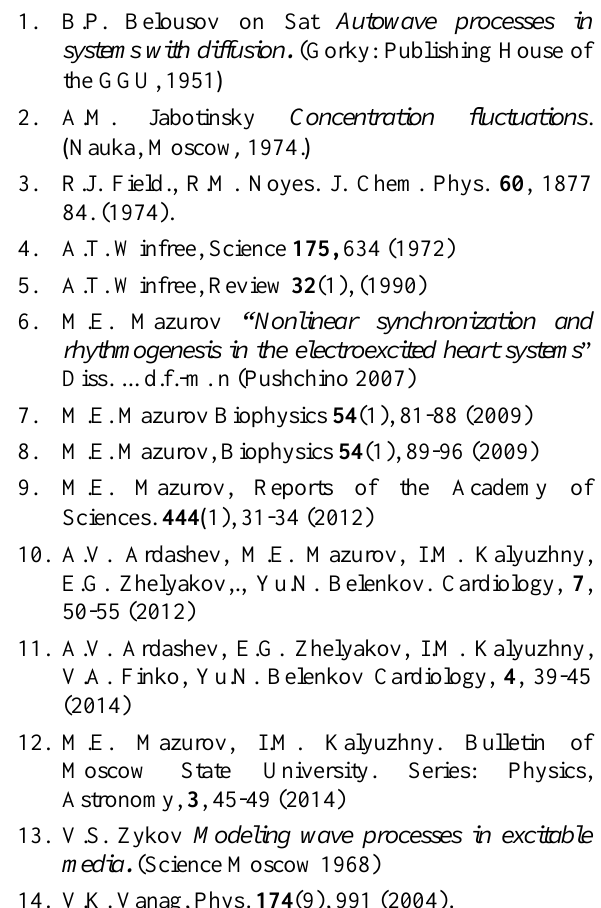
Fig. 14. Scheme of the main stages of the evolution of blood flow inside the cavity of the left ventricle. The wide blue arrows indicate the inflowing stream, the red arrows indicate the expelled stream, the thin blue arrows indicate the return flows, the green arrow indicates the direction of crosslinking of the inflowing stream and the stream formed by the residual volume; the blue line is the trabecula of the diastolic relief of the cavity, the red line is the trabecula of the systolic relief.